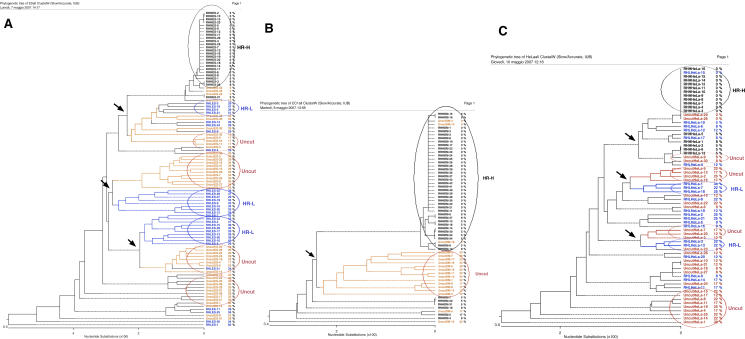
Methylation Patterns of Individual GFP DNA Molecules before or after HRClustalW analysis of individual GFP molecules (−50 to +420 bp relative to the DSB) derived from (A) ES, (B) Dnmt1−/−, and (C) Hela cell lines. Recombinant molecules were derived from cells sorted by GFP immunofluorescence as HR-L and HR-H in Figure 2B and 2C. To compare only methylation patterns, the same unrecombinant molecules shown in Figure 6A–6C were artificially transformed to recombinant molecules by substituting the I-SceI with the Bcg1 site. The percent of sequence variation is shown on the ordinate of the phylogenetic tree (dendrogram). The three main groups indicated in the dendrogram correspond to nonrecombinant (red) and recombinant sequences (black, HR-L and blue, HR-L clones). The variation in each group depends solely on the methylation pattern. The analysis has been performed on molecules derived from ~60 independent bisulfite reactions. The sequences that showed an identical pattern of methylation from the same bisulfite analysis were eliminated. For each sequence the percent of methylation is indicated at the bottom. The sequence analysis was performed using the MegAlign 7.0.1 a module of the Lasergene-DNASTAR software.